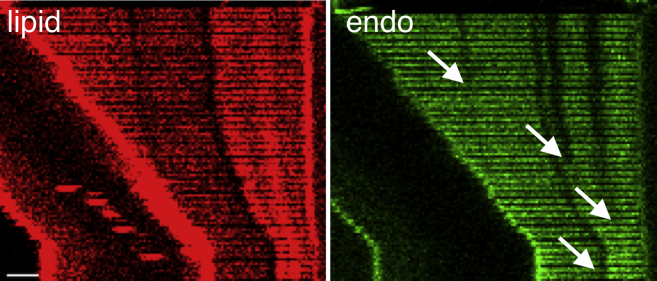
Scaffold Breakup upon Elongation of a Fully Covered Tube, Related to Figure 3Kymogram of a tube fully covered by a scaffold of N-BAR domain of endoA2, showing that the scaffold breaks apart upon elongation. This implies that fully and partially scaffolded tubes are equivalent, as far as FDS is concerned. Arrows point to scaffold breaks observable by our microscope. Scale bar, 2 μm.